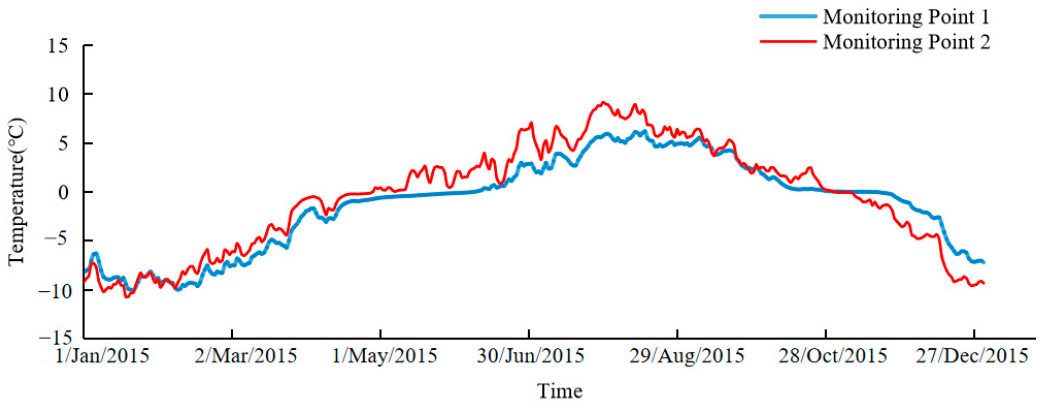
Figure 4. Variation of ground temperature (30 cm) under different cover conditions.